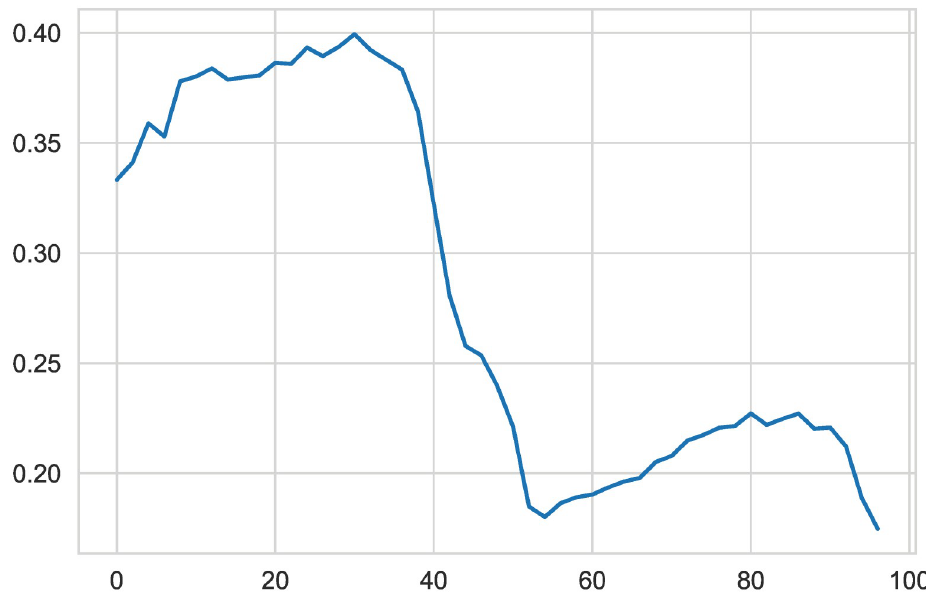
Fig 12. Centroid undersampling for LDA. LDA has a higher F2-measure when the undersampling is 30%, with a value of 0.3994, and has the lowest value at 54%; it is non-decreasing but increases after